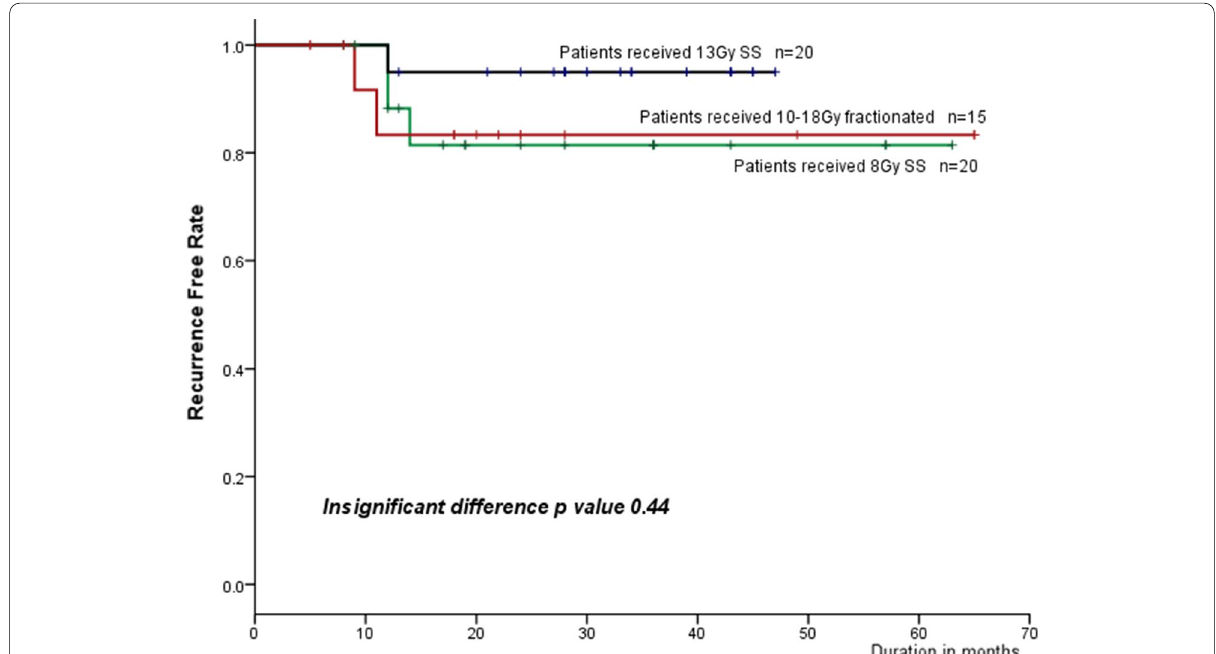
Fig. 3 The effect of different dose regimens on the recurrence rate. The curve showed insignificant difference between the used dose regimens; 13 Gy/1fx, 8 Gy/1fx, and 10–18 G fractionated